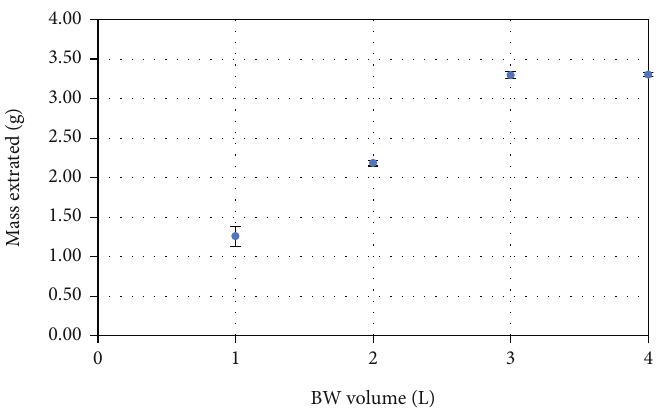
Figure 1: Masses extracted after adsorbing 1L, 2L, 3L, and 4 L of blanching water, expressed in g.